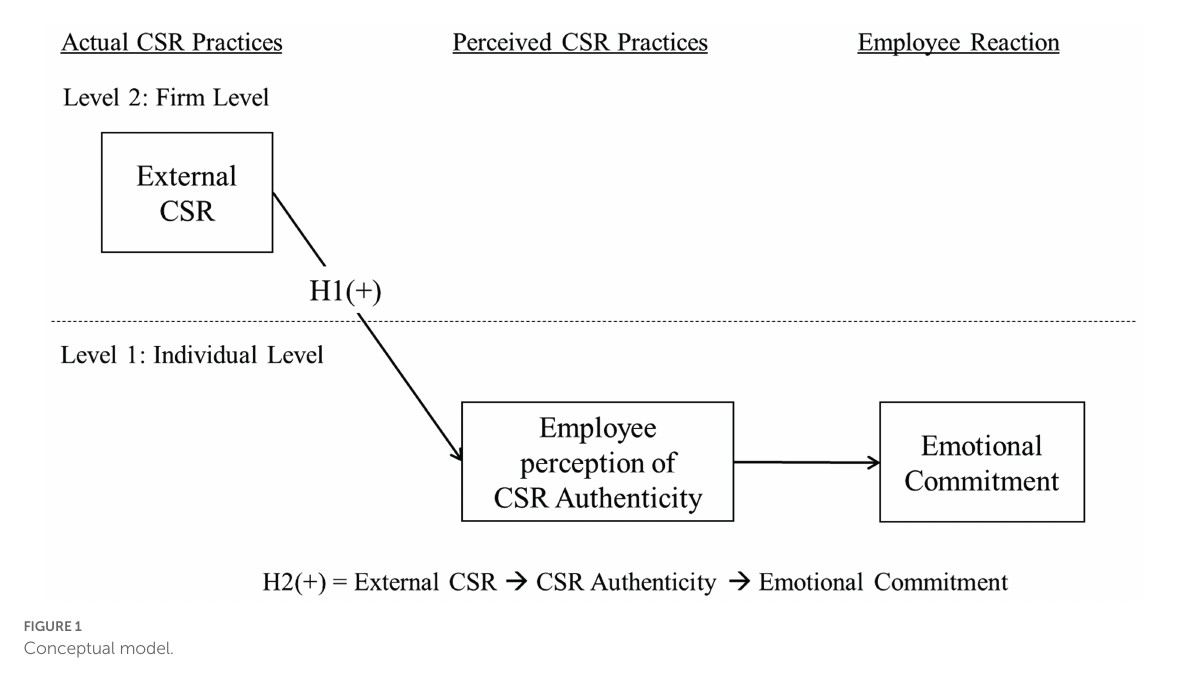
FIGURE 1 Conceptual